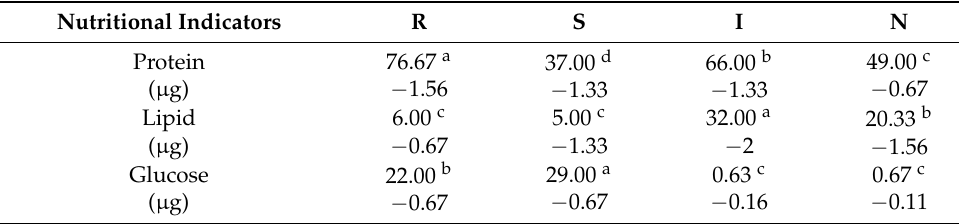
Table 1. Nutrient composition of the various feeds. Nutritional